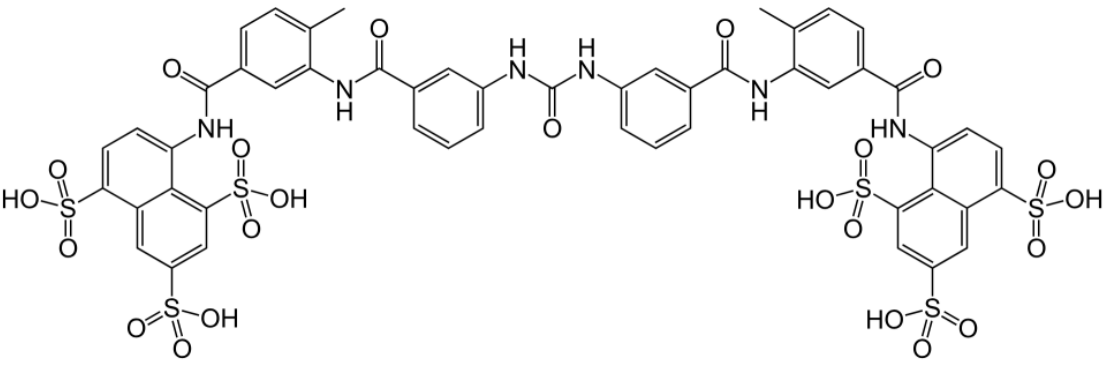
Figure 1. Molecular structure of Suramin. Suramin is a poly(hexa)sulfonate (hexa)sodium salt. Funding: This research received no external funding.